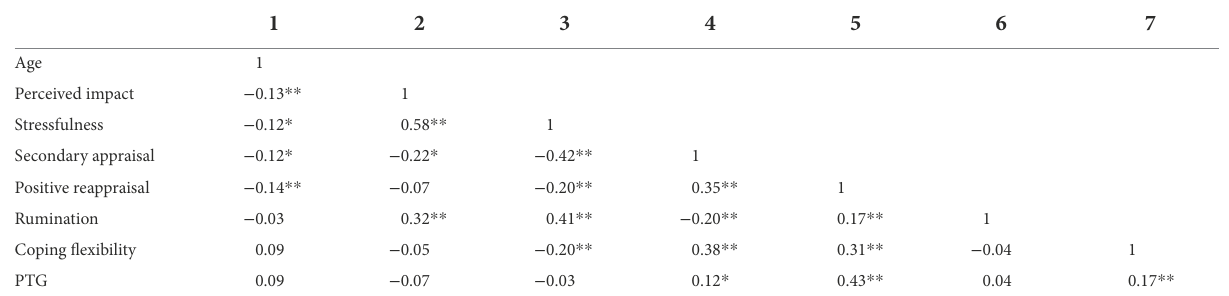
TABLE 2 Pearson correlations between the variables.